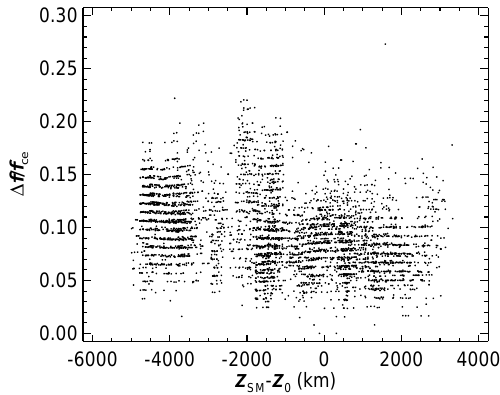
Fig. 7. The same as in Fig. 5 but as a function of the distance of the point of observation from the central position of the chorus source region measured along the Z S M coordinate.